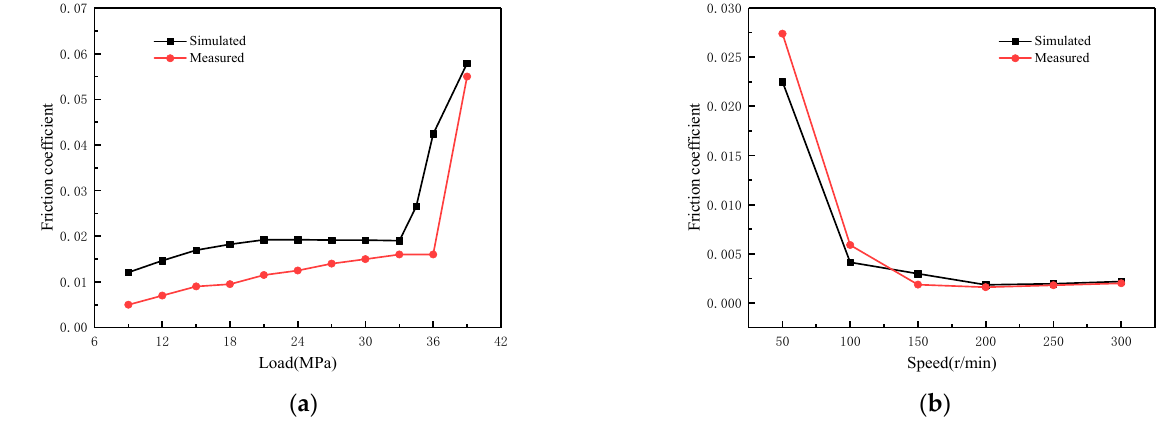
Figure 13. Comparison of theory and experiments. ( a ) T = 55 °C; ( b ) T = 70 °C.